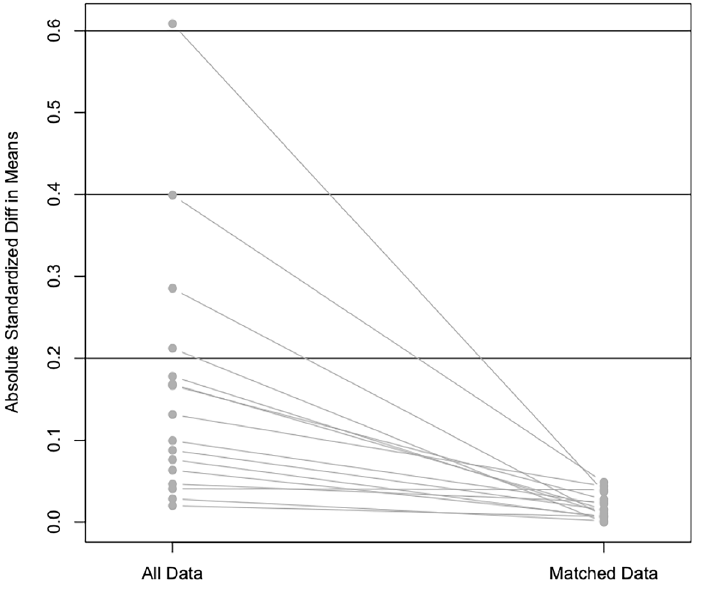
Fig 2. Standardized differences of means between covariates before and after match.